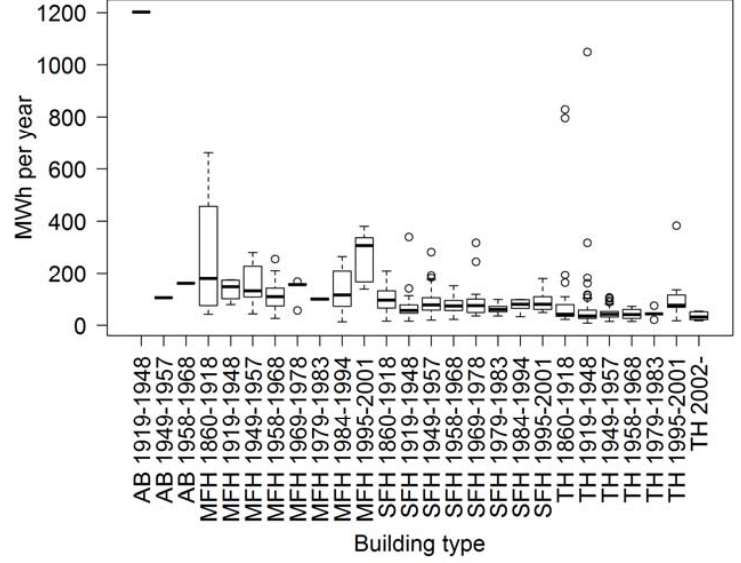
Figure 3. Total primary energy demand for heating and domestic hot water (MWh year − 1 ) for individual buildings (usual refurbishment). The boxes indicate the 25th–75th percentiles. The median and the upper and lower whiskers are also shown as well as outliers (indicated by circles).